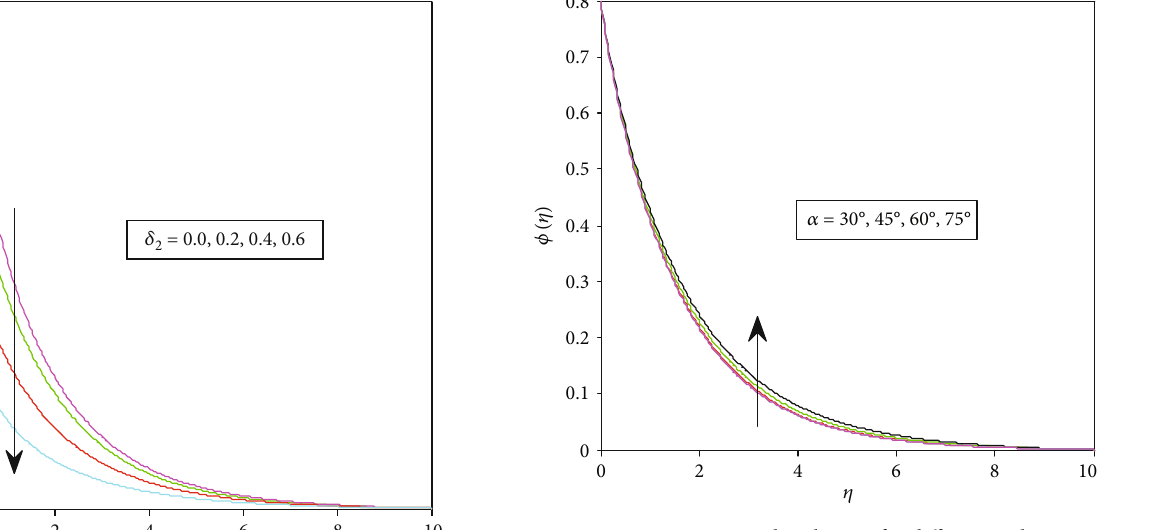
Figure 22: Concentration distribution for di ff erent inclinations.